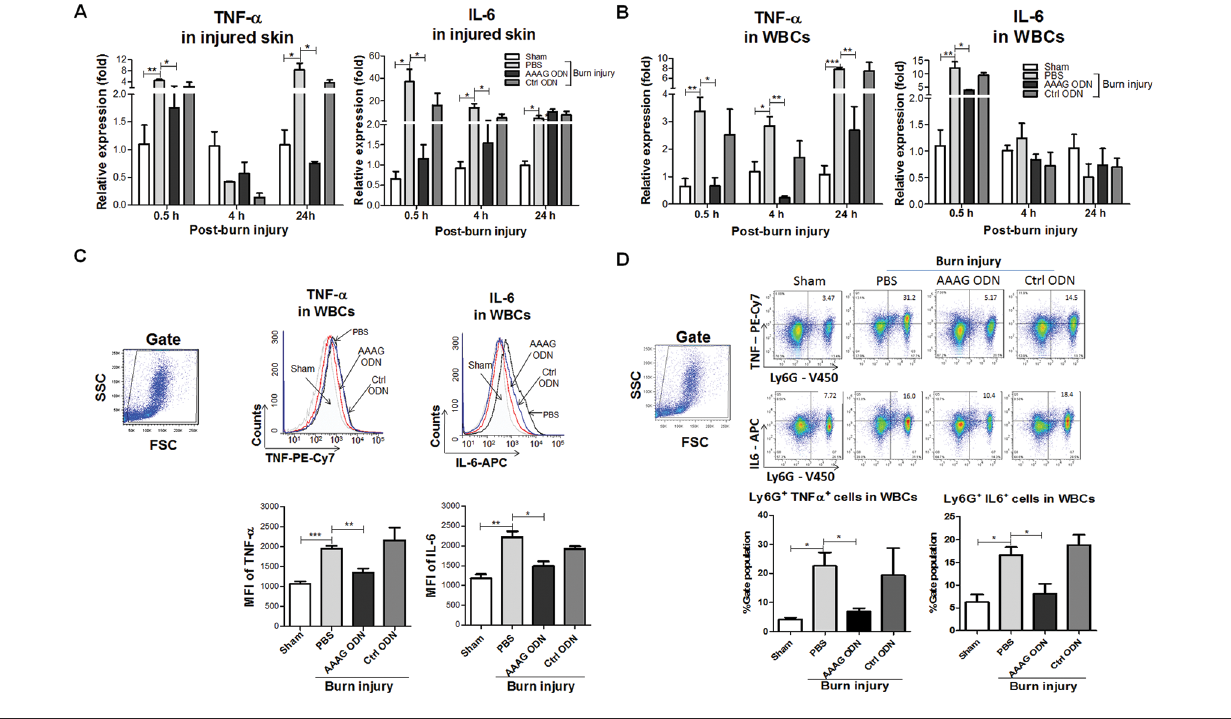
Figure 4. Effect of AAAG ODN on TNF- α and IL-6 production in skin tissues and WBCs of burn-injured mice. (A) Burn-injured skin tissues and (B) peripheral white blood cells (WBCs) collected at different time points post burn were used to detect the mRNA expression of TNF- α and IL-6 by qPCR. The WBCs harvested at 2 h post burn were treated with monensin in vitro for 2 h, and then subjected to flow cytometric analysis to detect (C) intracellular expression of TNF- α and IL-6 and (D) the percentage of TNF- α or IL-6 positive neutrophils. Data are represented as mean ± SEM (n = 3 mice/group). *P < 0.05, **P < 0.01, ***P <